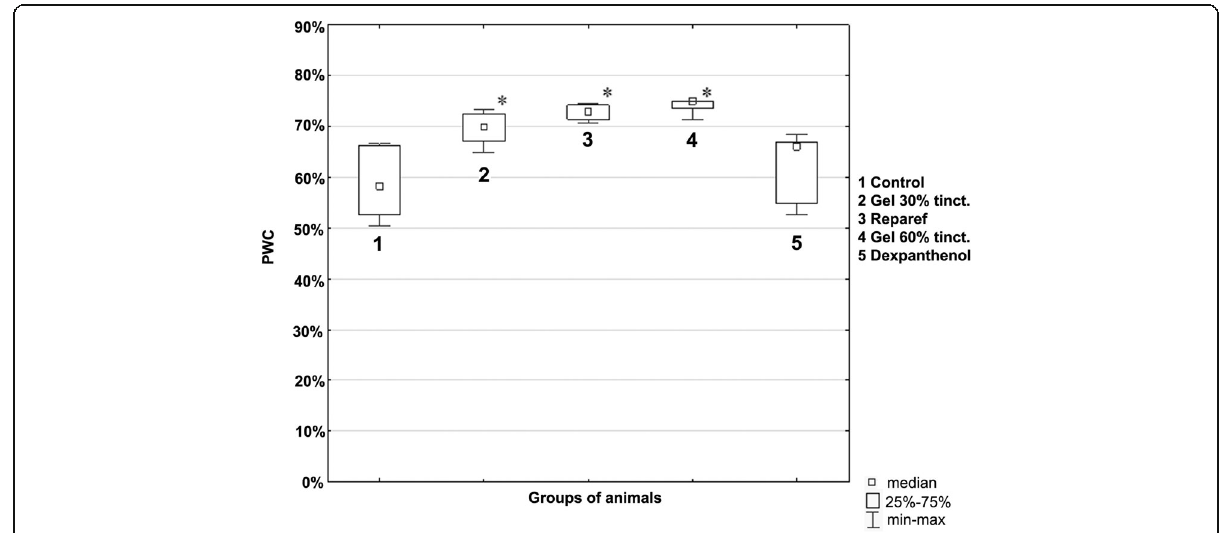
Fig. 2 Percentage of wound closure per day 9. * p < 0.05 vs control group